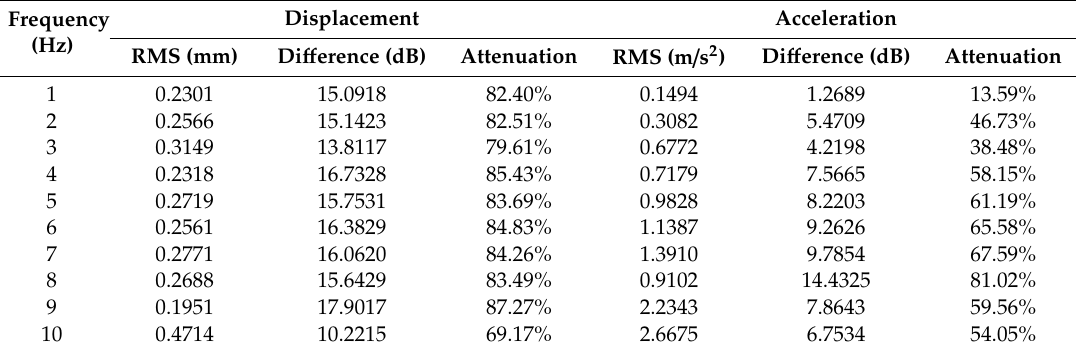
Table 4. Vibration response of pipeline under SMVS control.